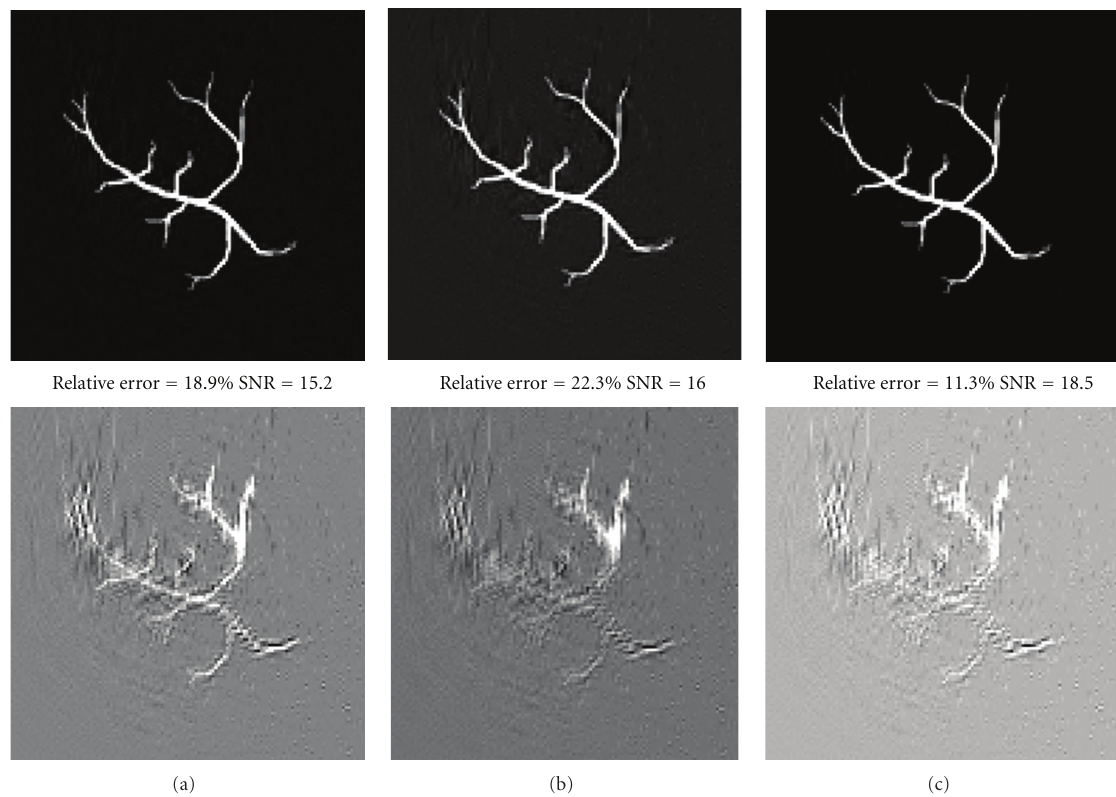
Figure 2: Image reconstructions in (a) with L1magic, (b) with SPGL1, and (c) with ADM, using 56 detection angles and 64 Fourier samples per angle with a uniform distribution at 90-degree curve noisy observation with SNR =